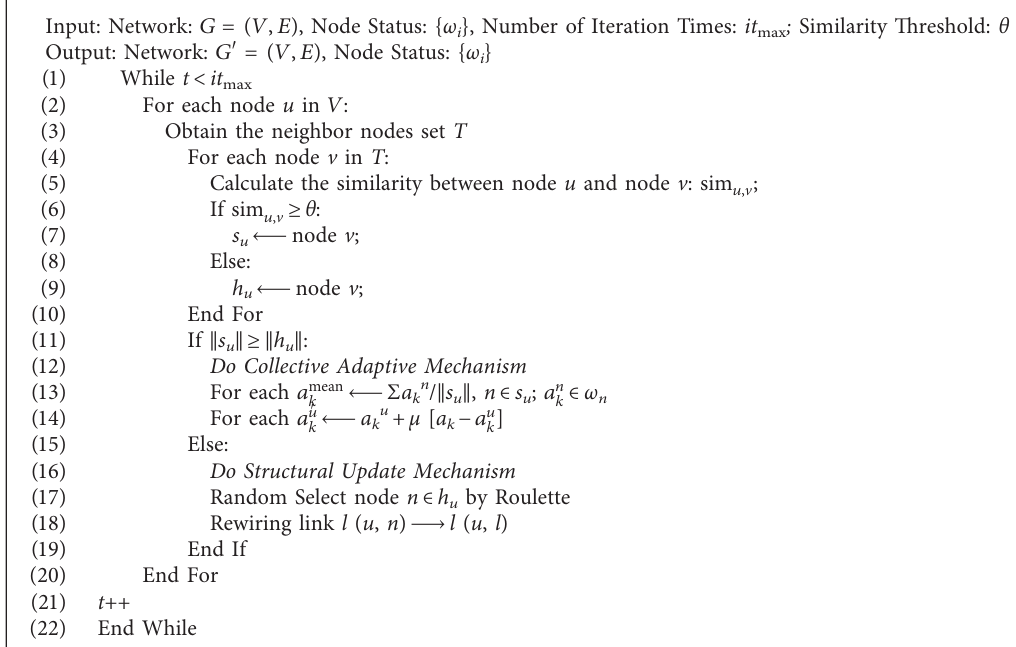
A LGORITHM 1: Simulated social identity